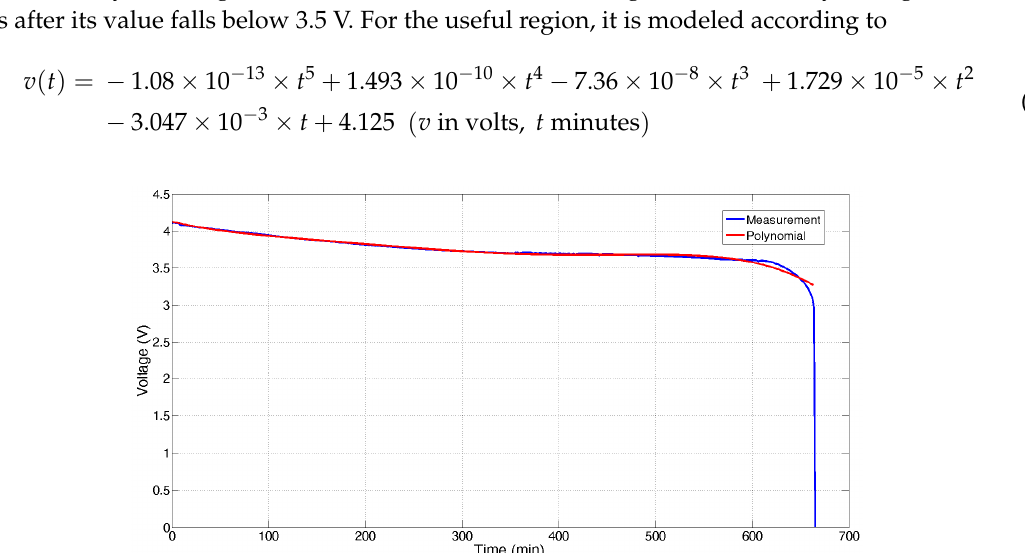
Figure 8. Experimental battery voltage (V) vs. time (min) for a constant 60 mA discharge.